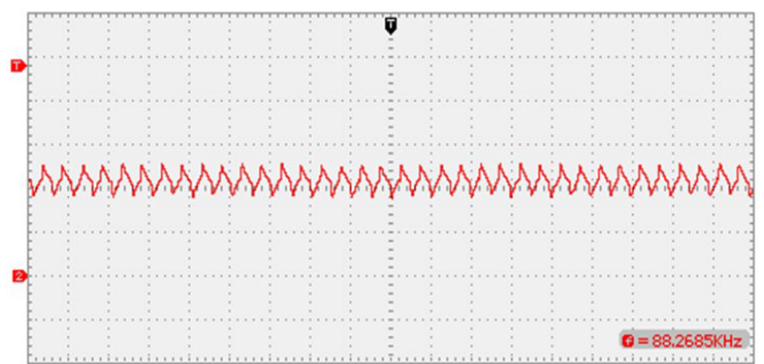
Figure 17. Capacitor voltage V C 1 (vertical scale 5 V/div).